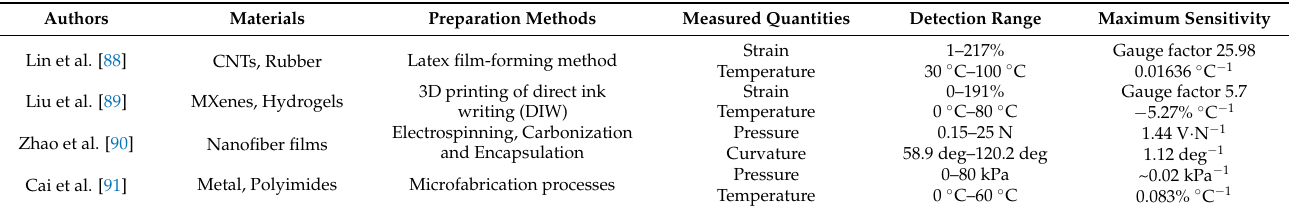
Table 1. Summary of single sensors with multiple